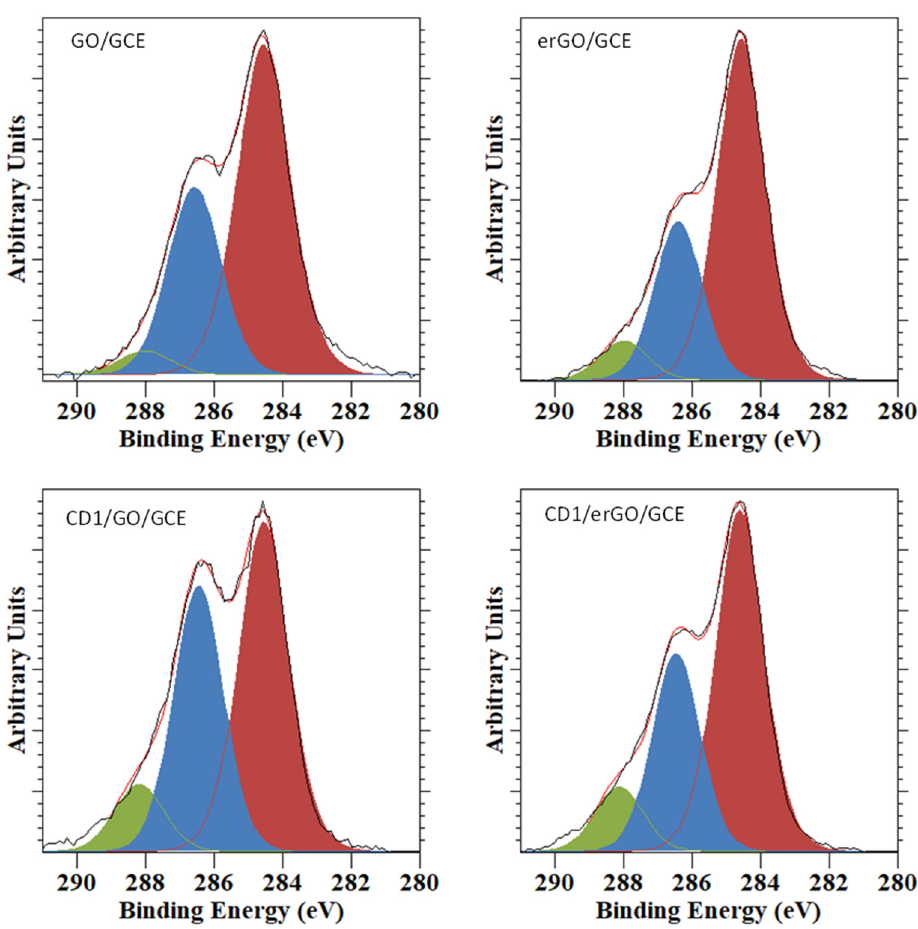
Figure 4. C 1s XPS spectra recorded from the di ff erent samples.